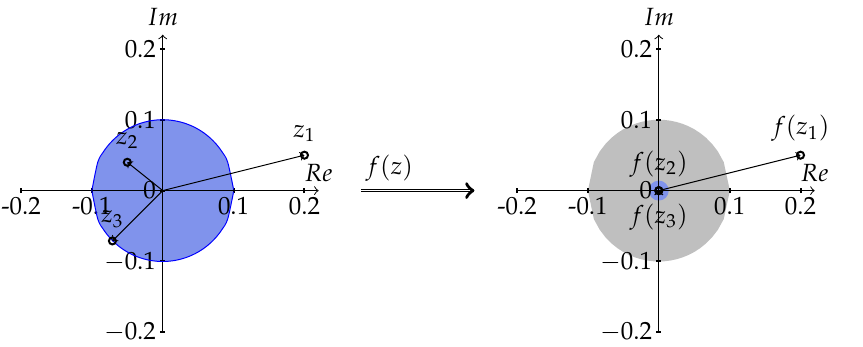
Figure 1. The nonlinear activation function f (with α = 0.1) maps z 1 to z 1 and z 2 , z 3 to zero, where | z | > 0.1, | z | < 0.1 and | z | = 0.1. The position of points outside the blue circle does not change, 2 3 1 but all points in the circle will be